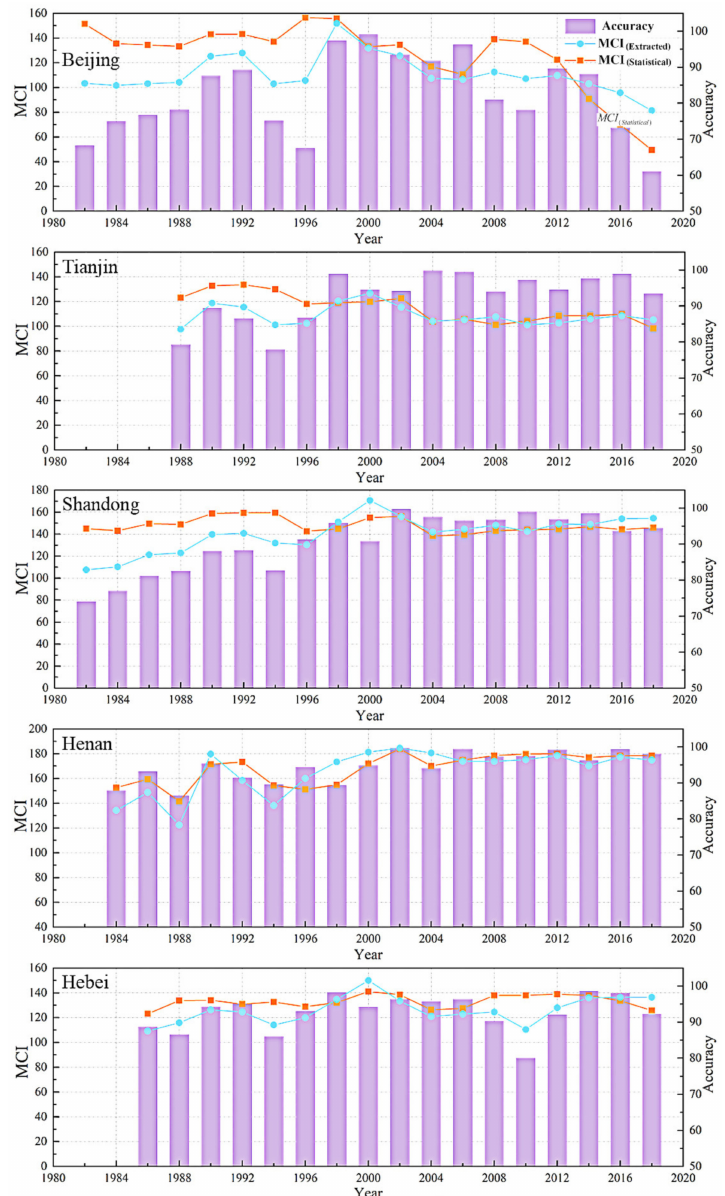
Figure 5. Assessment of the extraction accuracy of the MCIs using a comparison with statistical data for the NCP from 1982 to